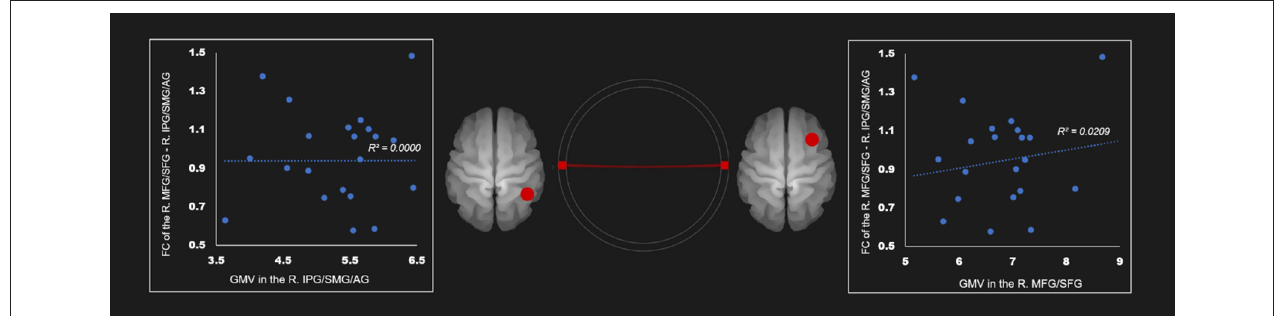
FIGURE 4 | Correlation between FC and gray matter volume in the right executive control network in the AUD group. Red line represents the positive functional connectivity between ROIs, respectively. FC, functional connection; AG, angular gyrus; AUD, alcohol use disorder group; IPG, inferior parietal gyrus; MFG, middle frontal gyrus; R, right; SFG, superior frontal gyrus; SMG, supramarginal